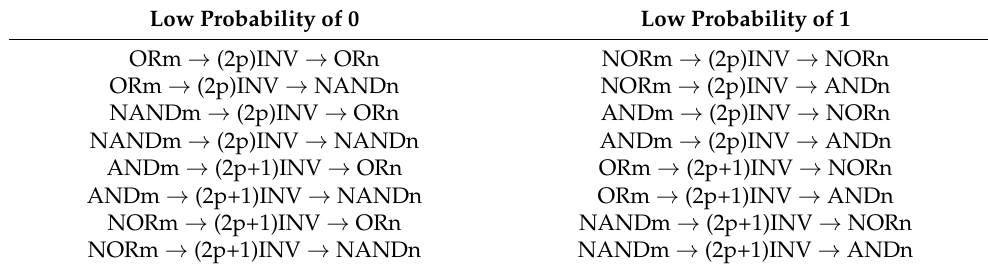
Table 1. HT structure